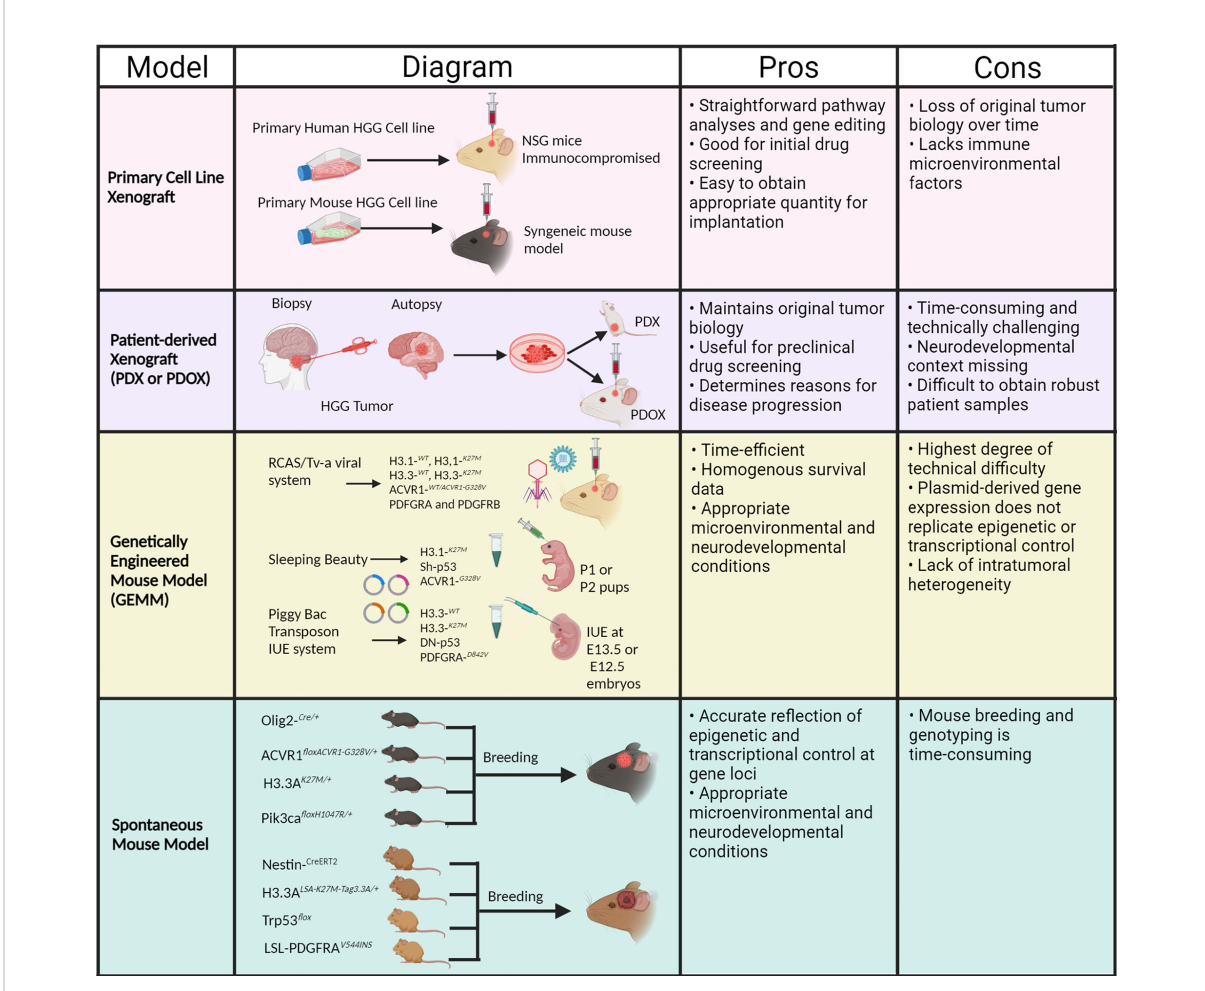
FIGURE 2 Schema of preclinical mouse models and associated pros and cons for pHGG. (Created with